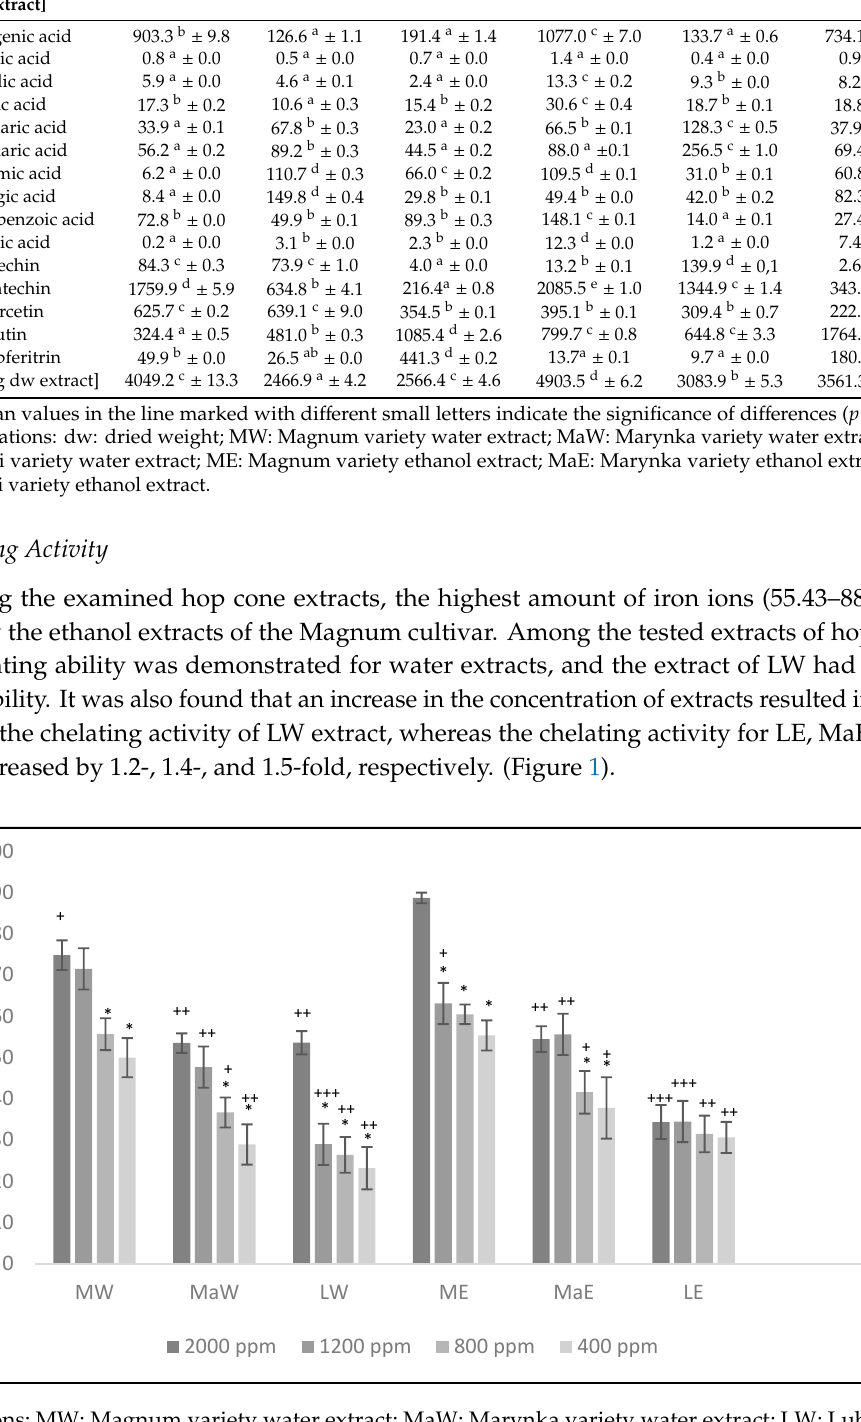
Figure 1. Chelating activity of extracts of Humulus lupulus hops.